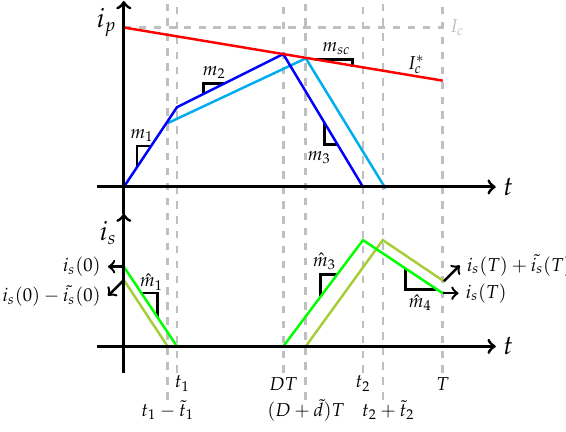
Figure 3. Primary- and secondary-coil currents for the Period-1 orbit and a perturbed